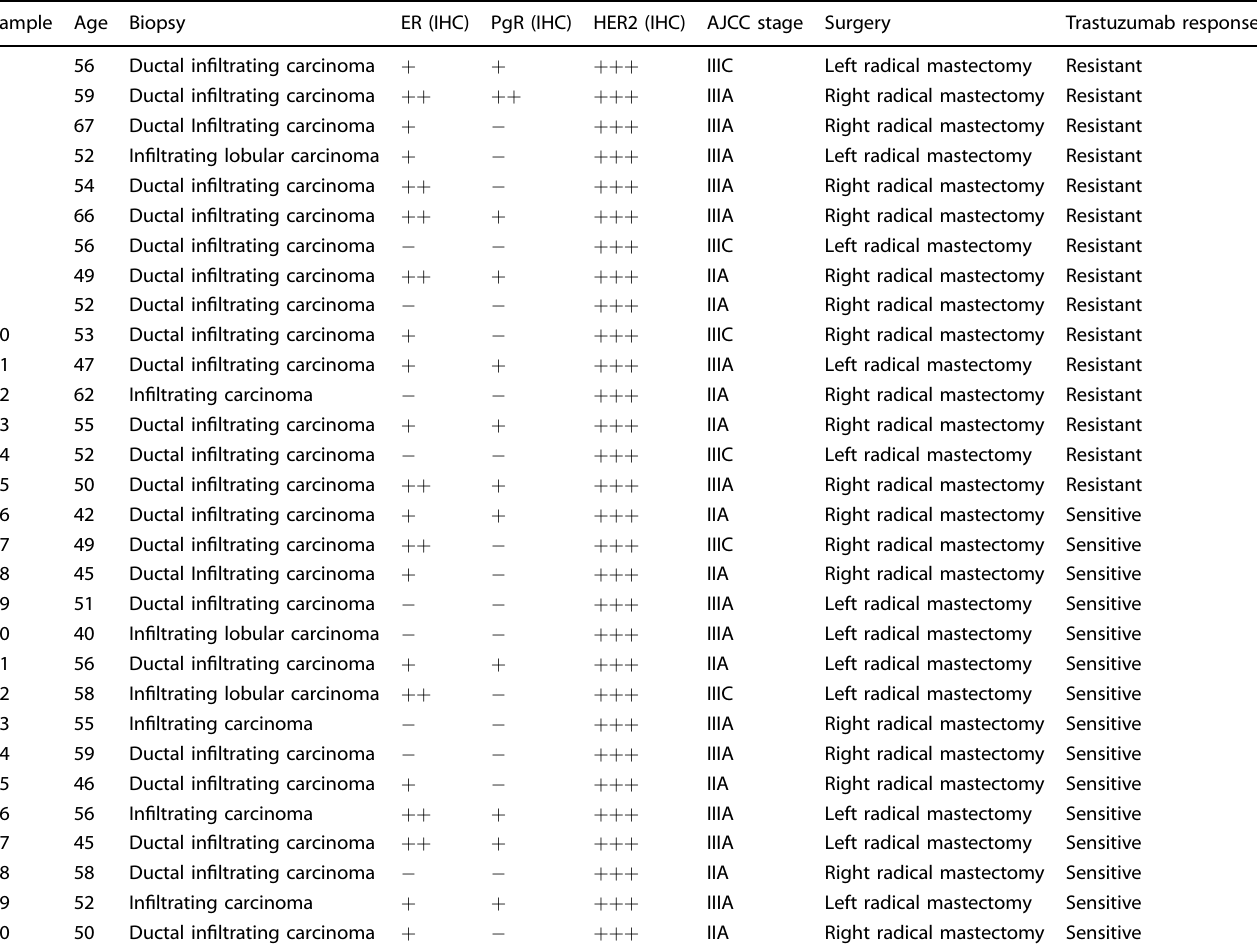
Table 2. Clinical and pathological information for HER2-positive breast cancer patients treated with trastuzumab Sample Age